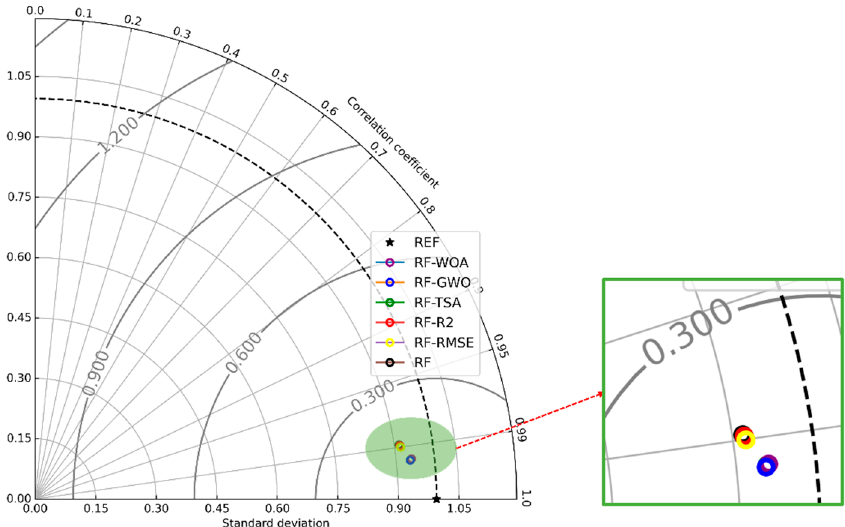
Figure 10. Taylor diagram of the training results for the six developed models.